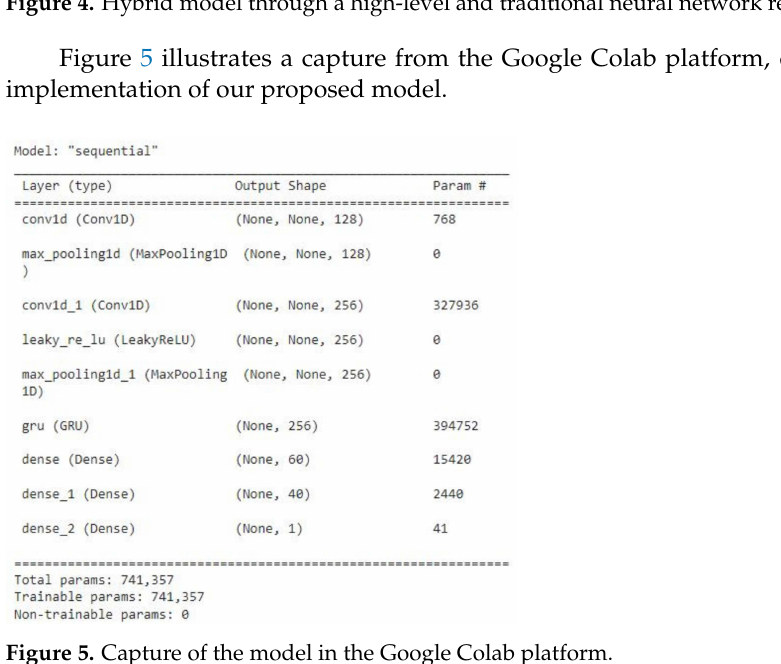
Figure 4. Hybrid model through a high-level and traditional neural network representation.